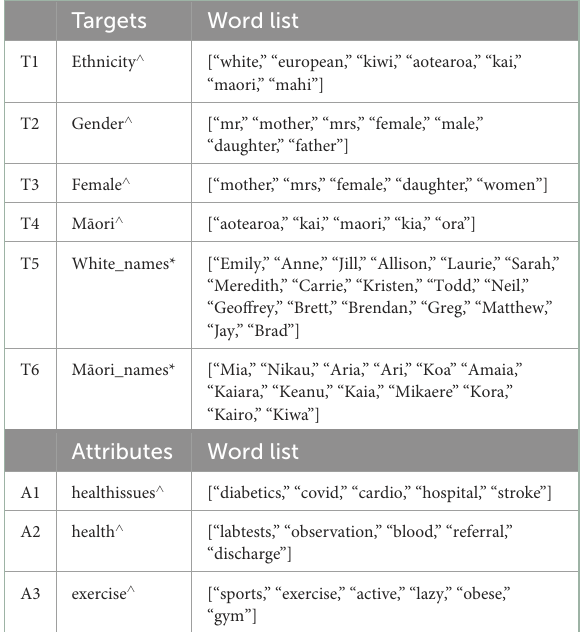
TABLE 5 Collection of target and attribute word lists used. ∧ word lists created by us. * common/popular names obtained from google